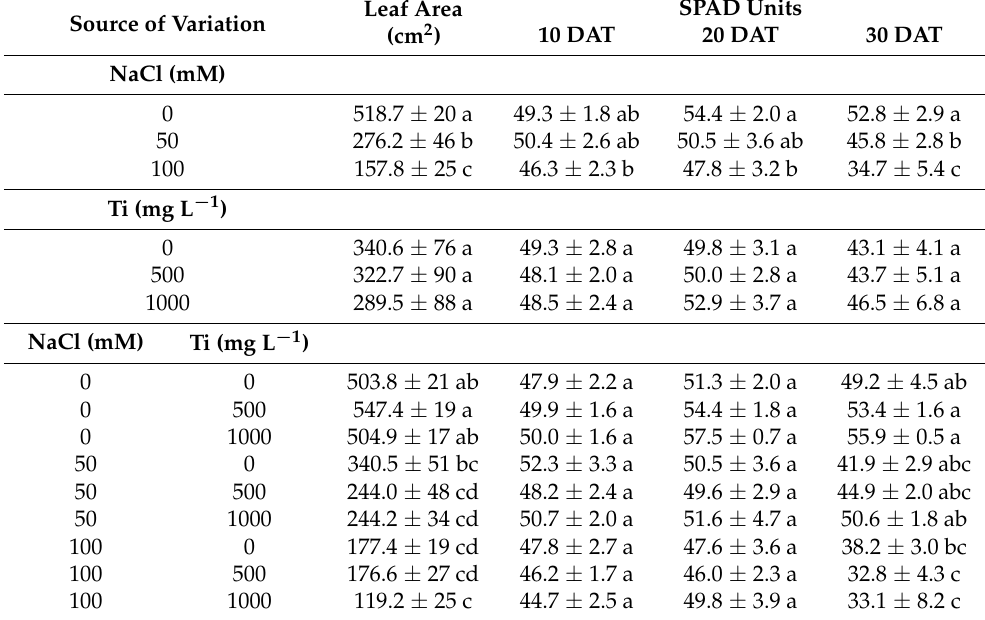
Table 2. Main and interaction effects of NaCl and TiO 2 on leaf area and SPAD units of tomato ( Solanum lycopersicum L.) seedlings cv. Rio